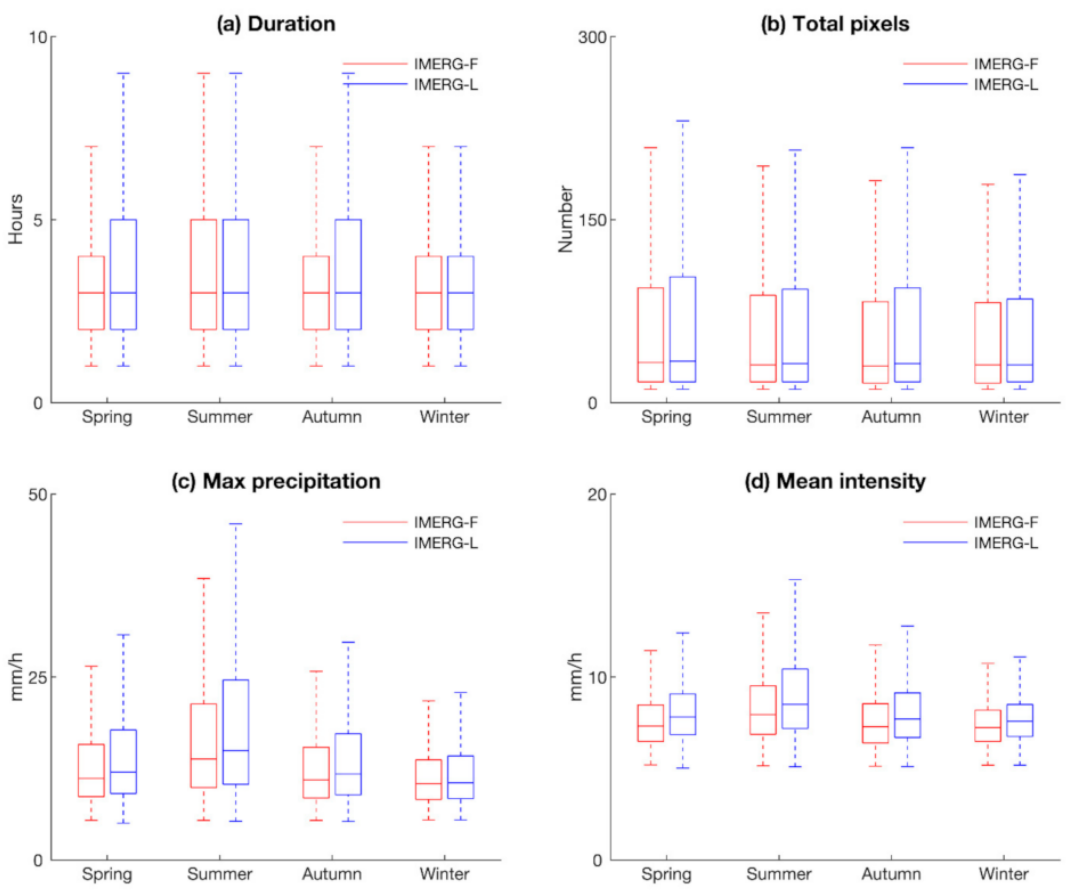
Figure 9. Features of hourly scale extreme precipitation events from 2000 to